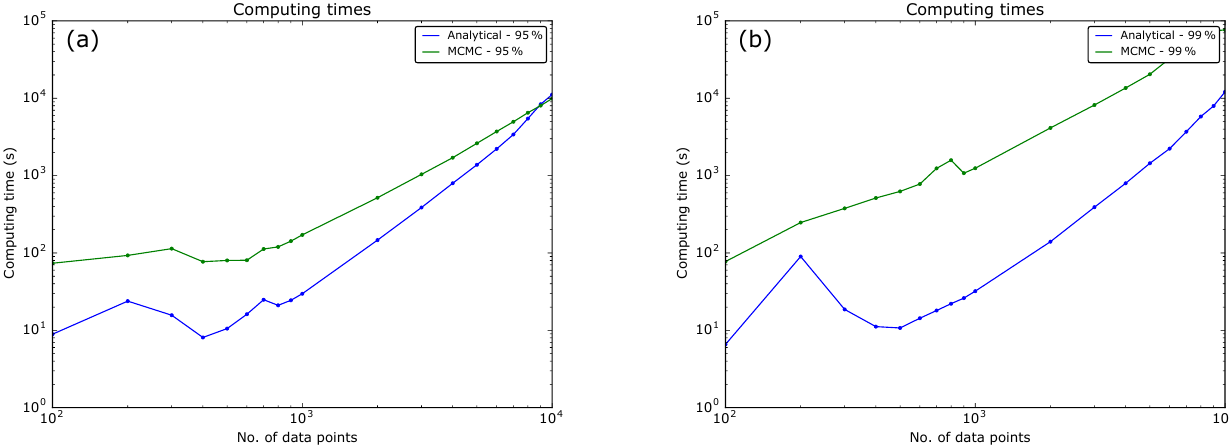
Figure E1. Computing times for generating the WOSA periodogram with analytical (blue) and MCMC (green) confidence levels, in function of the number of data points (disposed on a regular time grid). Log–log scale. (a) 95th percentiles. (b) 99th